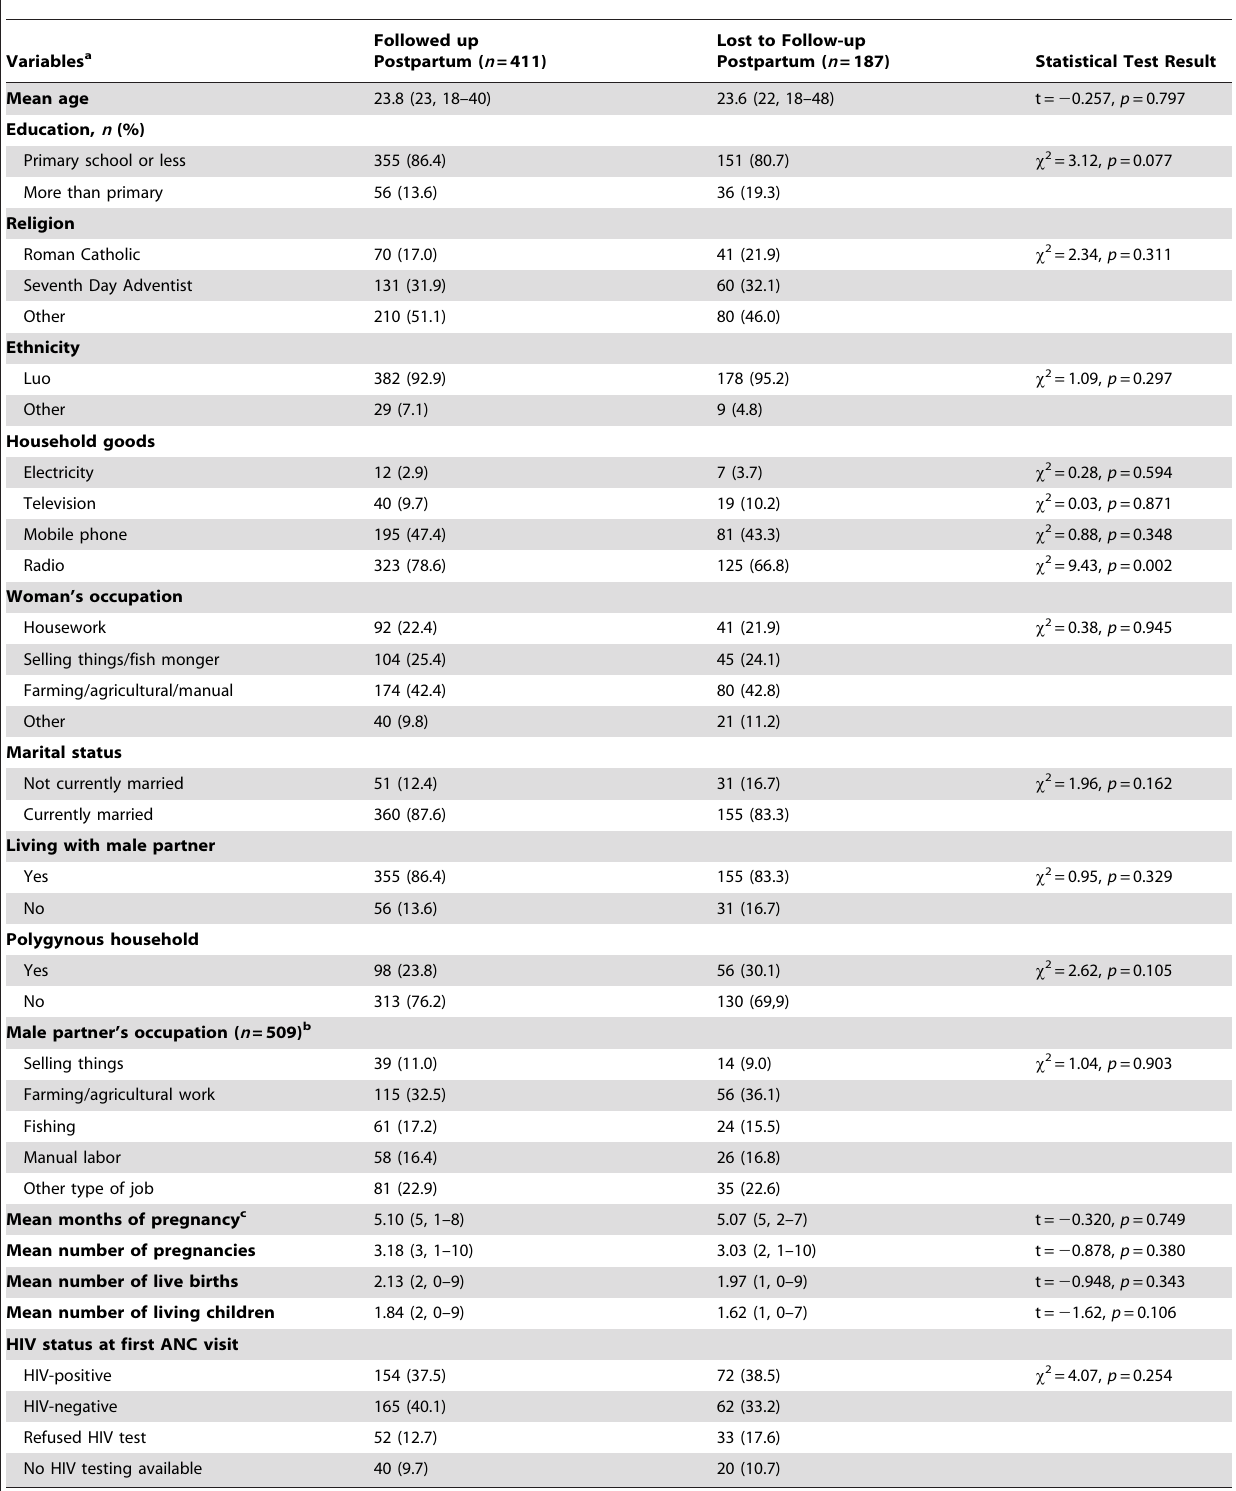
Table 1. Comparison of baseline socio-demographic characteristics of MAMAS Study participants followed up after the birth versus lost to follow-up ( n =